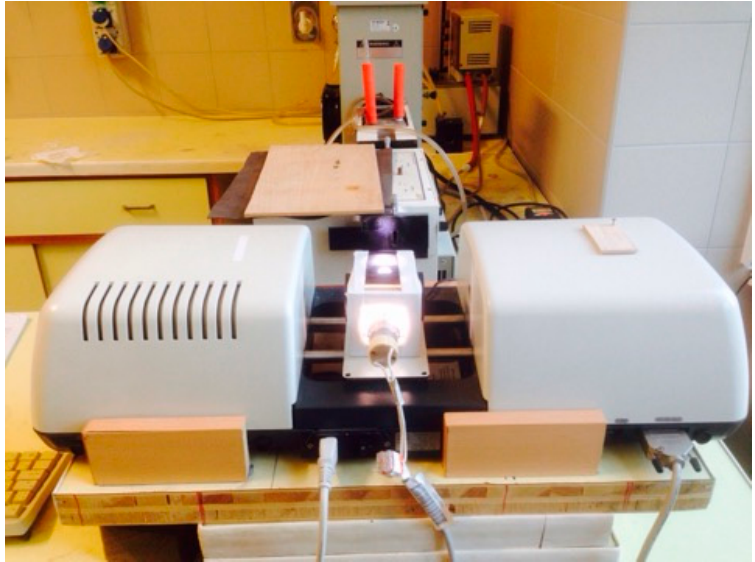
Figure 1. Assembly for photocatalytic experiments.